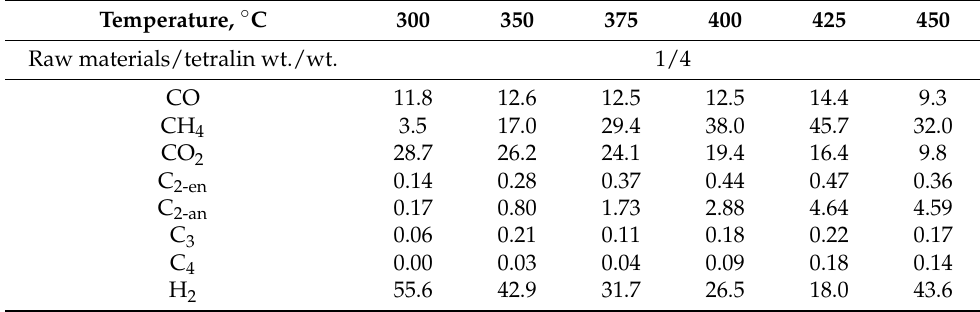
Table 4. Influence of dilution and reaction temperature on the composition of gaseous products obtained by thermal dissolution of